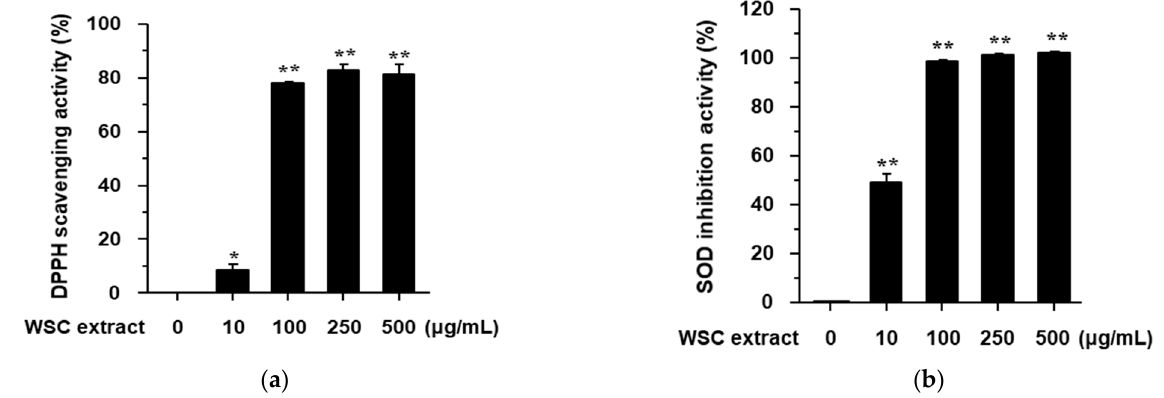
Figure 2. Antioxidant effects of WSC extract: ( a ) The DPPH scavenging activity of WSC extract was measured at the indicated concentrations; ( b ) The SOD inhibition activity of WSC extract was measured at the indicated concentrations. Values are expressed as the mean ± standard deviation of three independent experiments. *, p < 0.05; **, p < 0.005 versus the control.